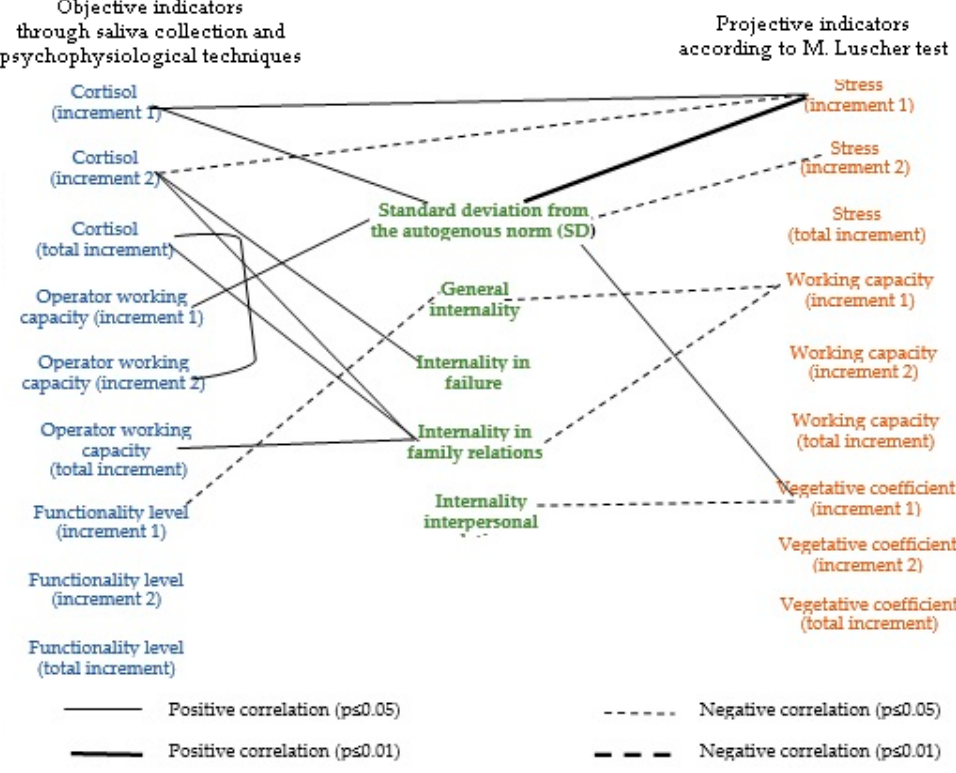
Figure 3. Correlation pleiad of relationship between objective and projective indicators of fly-in-fly-out (FIFO) workers’ stress and working capacity at an oil and gas production enterprise.